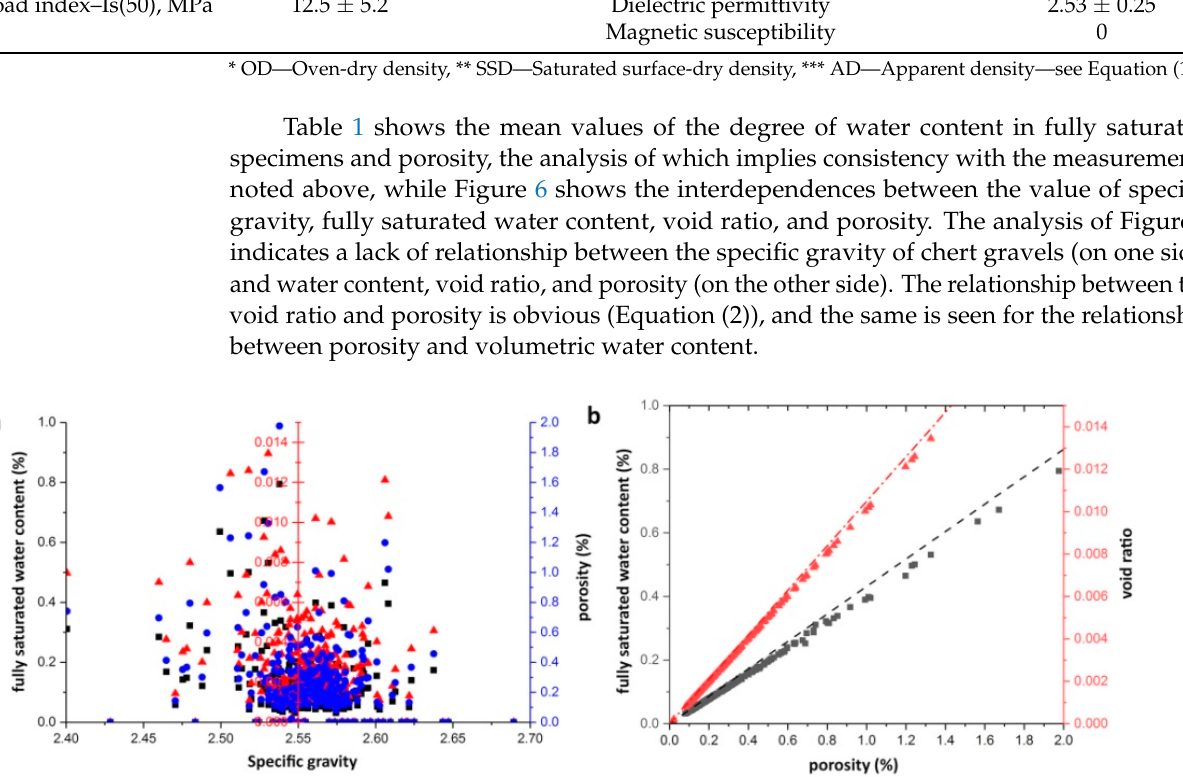
Figure 6. ( a ) The relationship between the values of specific gravity, fully saturated water content (in black), void ratio (in red), and porosity (in blue); ( b ) the relationship between the values of porosity, fully saturated water content (in black), and void ratio (in red).